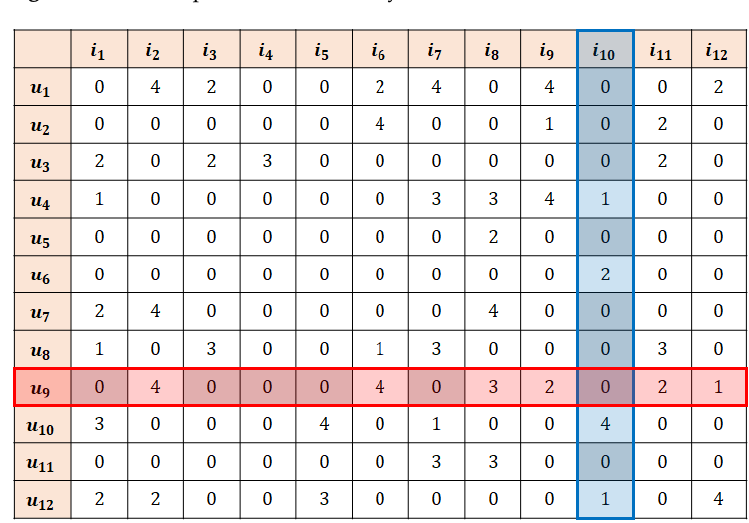
Figure 4. An example of missing data imputation of k-RRI (step 2). Lastly, the set of users 𝒰 1 selected in step 3 𝑖𝑠 ∅ , whose similarity with the active user 𝑢 1 is between threshold 𝜂 3 = 0.1 and 𝜂 2 = 0.2 , and the set of items ℐ 1 is {𝑖 4 } , whose similarity with the active item 𝑖 1 is between threshold 𝜃 3 = 0.1 and 𝜃 2 = 0.3 . Accordingly, the ratings that {𝑖 4 } receives from all users become the set of key neighbors 𝒩 1,1 in step 3, and the missing data to be imputed are the unrated values among the key neighbors (the parts marked in Figure 5). 4.2. Threshold Reset Process Unlike EMDP and AutAI, k-RRI uses a recursive algorithm with stepwise iteration, whereby the final imputation matrix can vary depending on the recursive structure. The imputation error can be defined as an error incurred by imputing an empty dataset with an arbitrary value. In k-RRI, missing data are imputed in a given step based on the actual rating histories and the virtual data imputed in the preceding step. Therefore, not only does the imputation error affect the step concerned, but it is also carried forward to the next step, as expressed by Equation (10), where 𝑘 is the number of recursive steps, 𝜀 𝑟 is the imputation error incurred in the 𝑟 -th step, and 𝛼 𝑖 and 𝛽 𝑖 are constants.